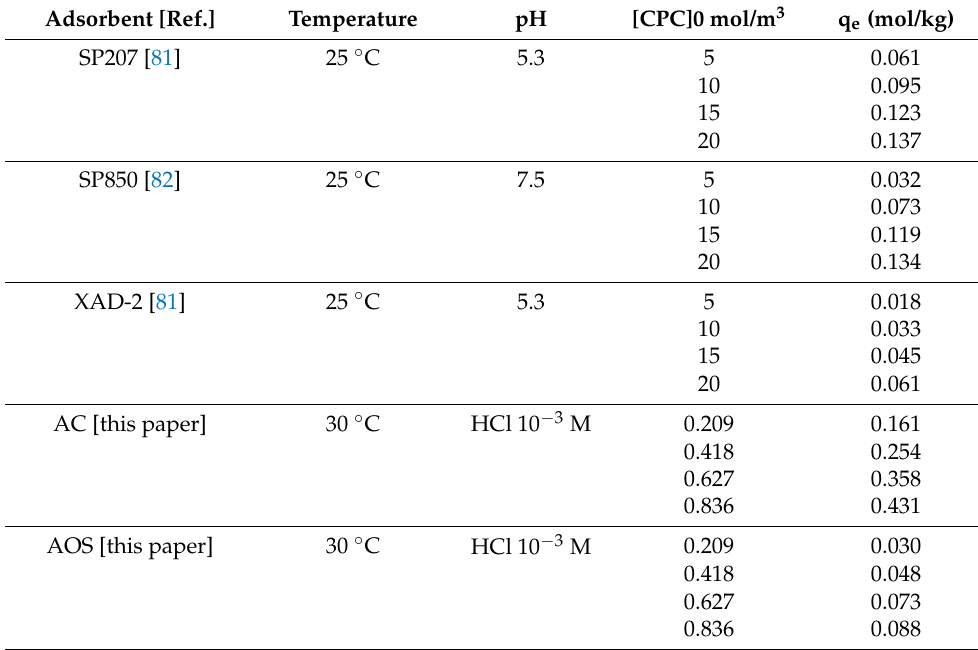
Table 7. Cephalosporin C adsorption capacity onto different